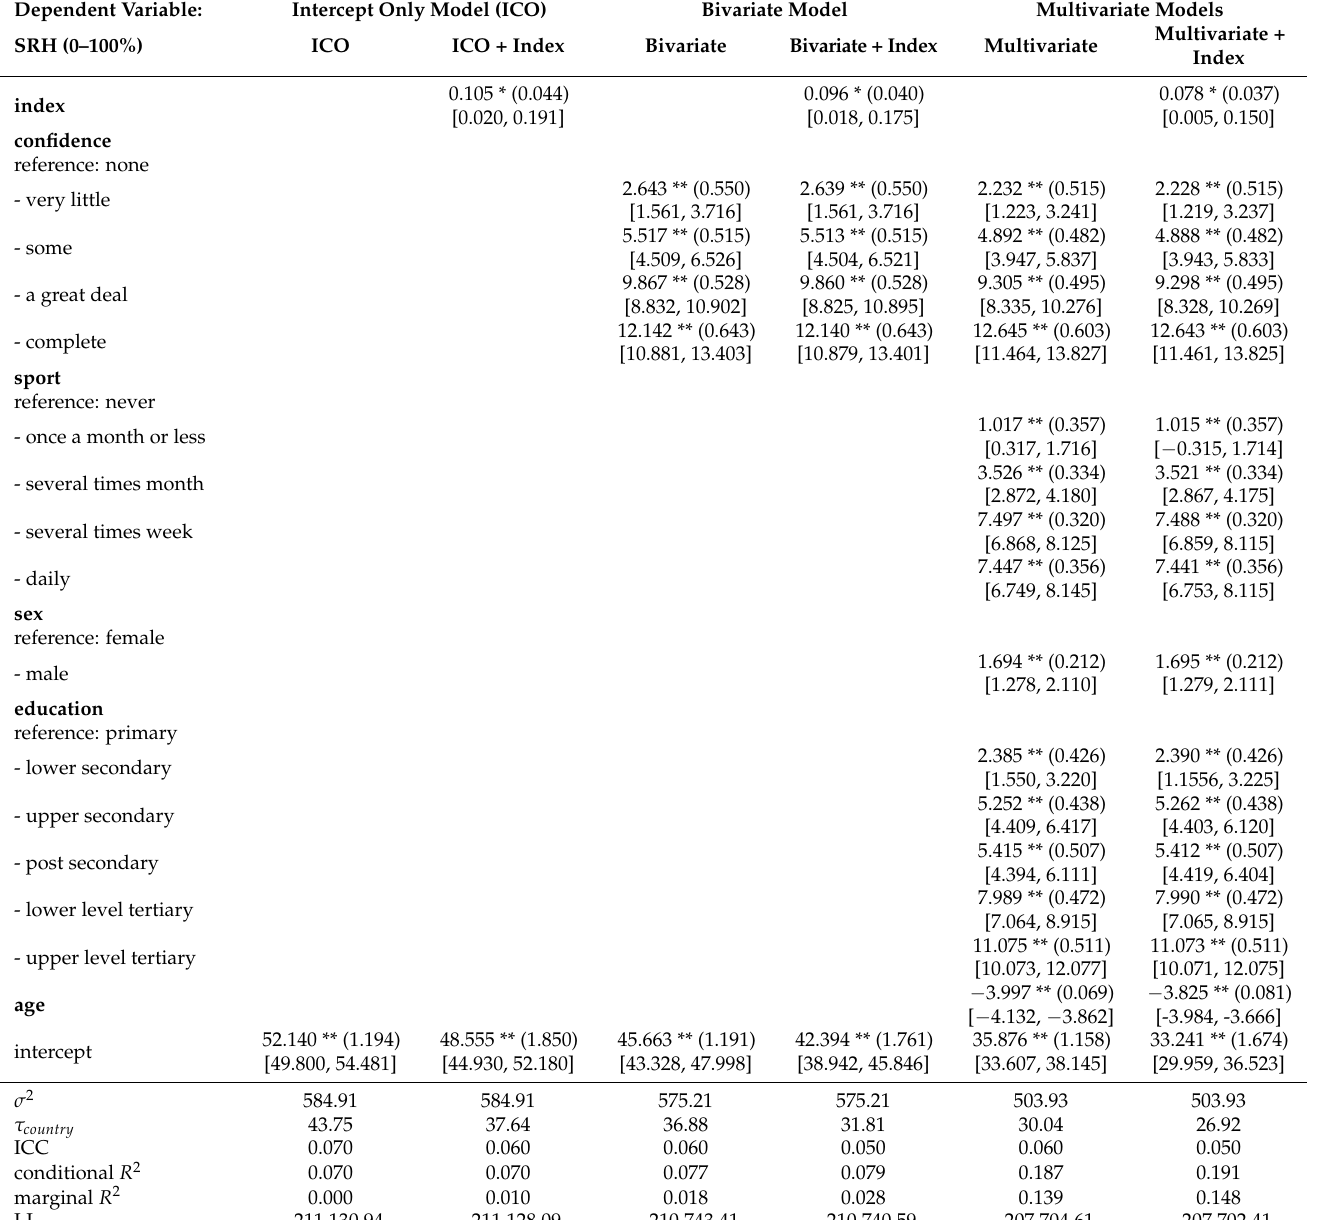
Table 5. Varying intercept constant slope model: estimation (standard error) [95% confidence